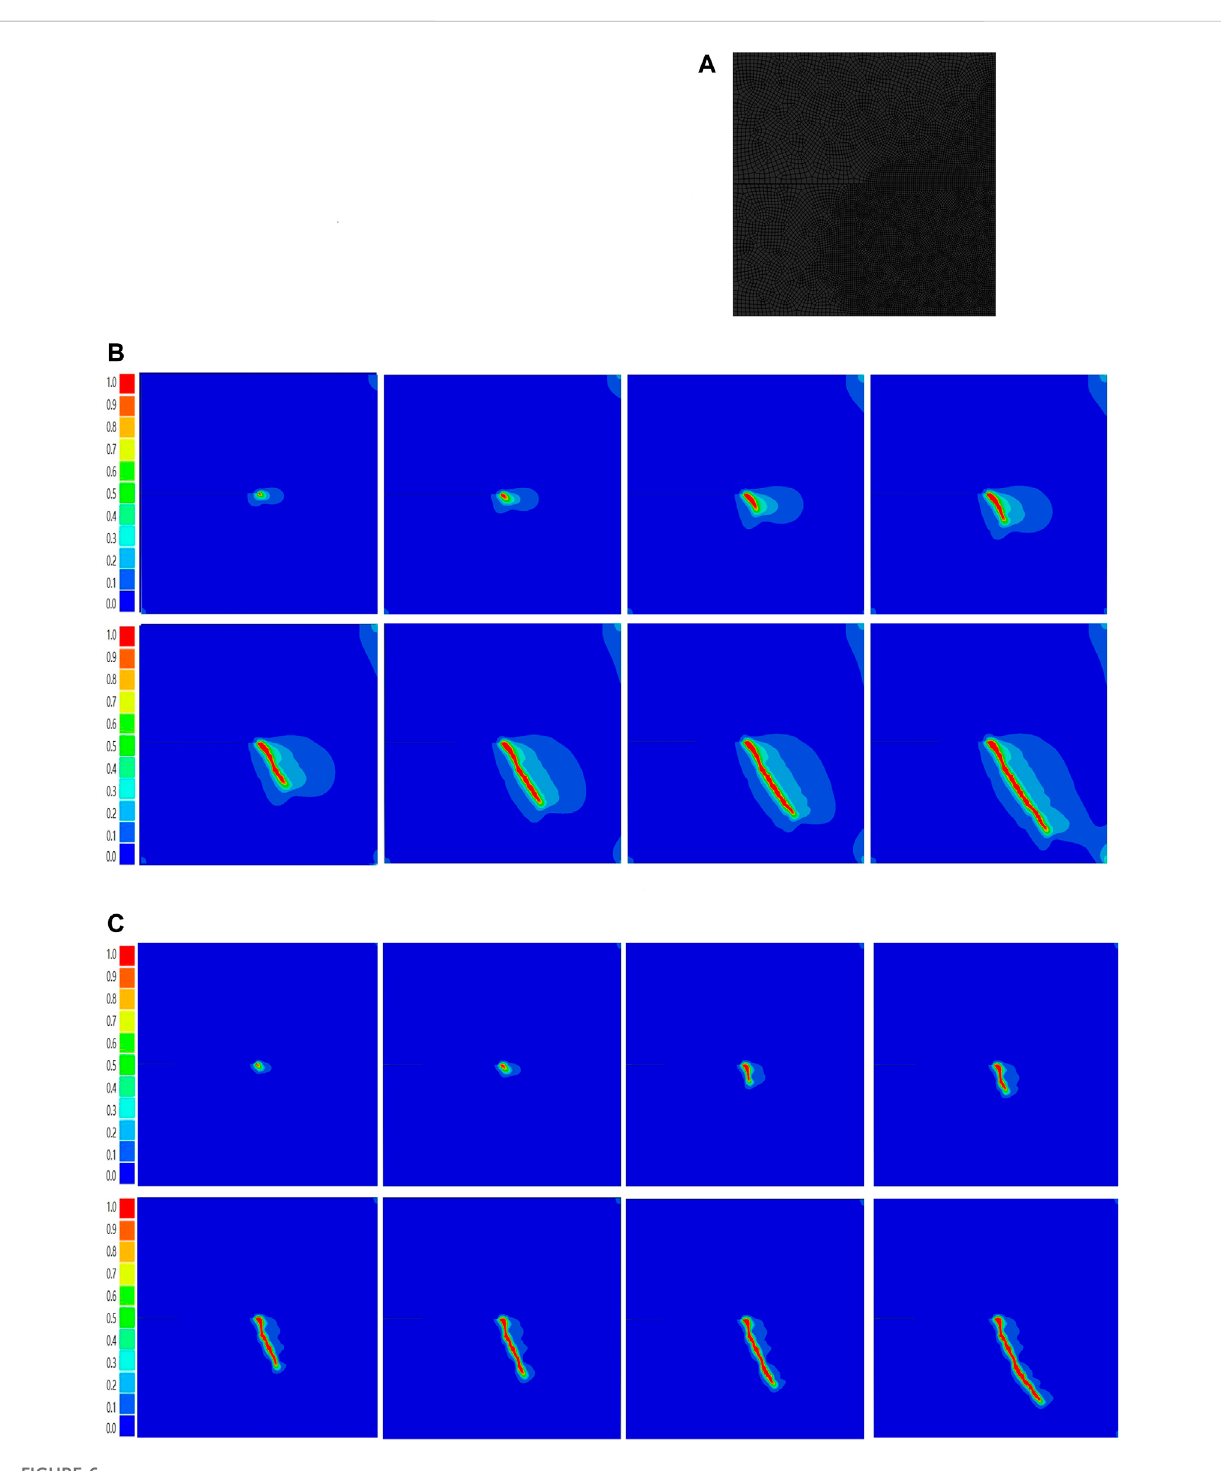
complex and closely resembles a rock fracture section during the simulation of the tensile square plate. Conversely, the crack growth path generated by the traditional degradation function appears more linear. These fi ndings indicate that our proposed phase- fi eld fracture model possesses distinctive characteristics in accurately capturing crack